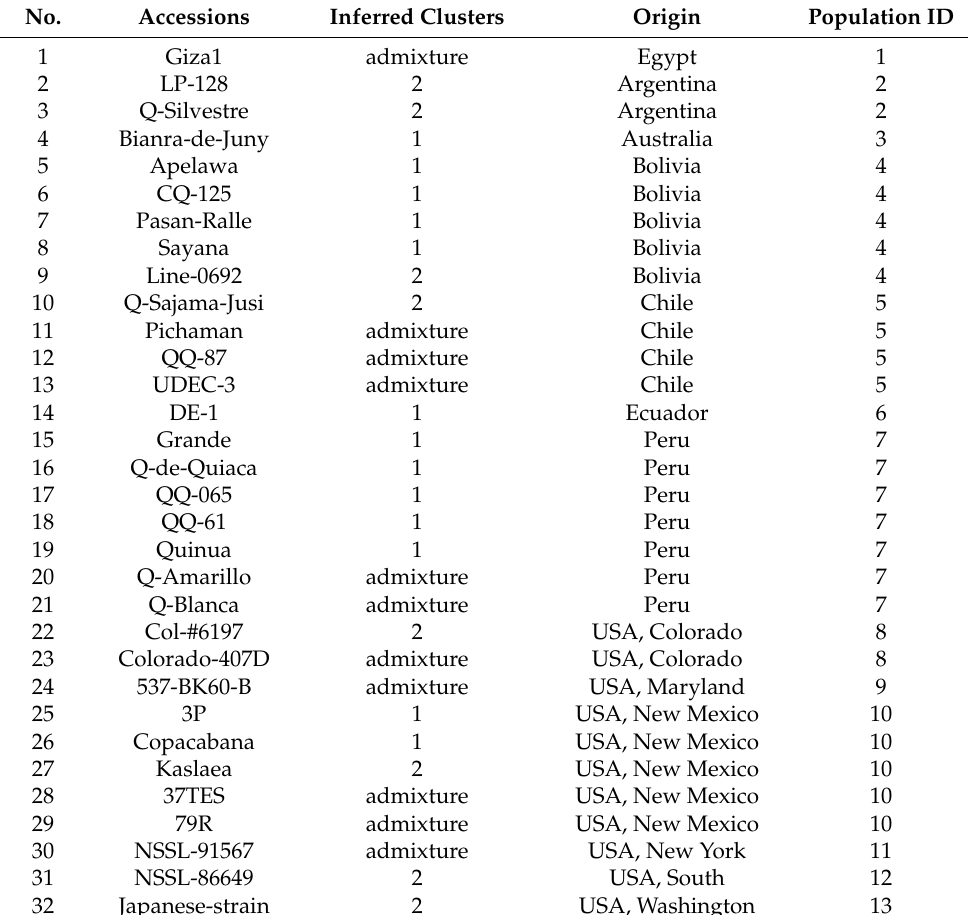
Table 5. Classification of Quinoa genotypes and their inferred subpopulation identities.